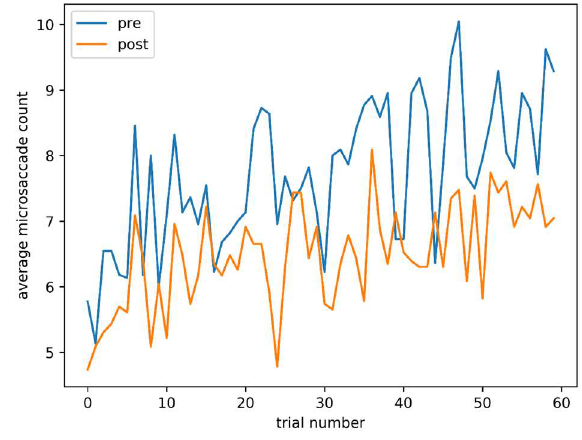
Figure 4: Sensitivity analysis, showing mean (line) and bootstrapped 95% confidence range (shaded area) for the pre-post caffeine microsaccade count correlation for anal- ysis based on 3 – 60 trials.